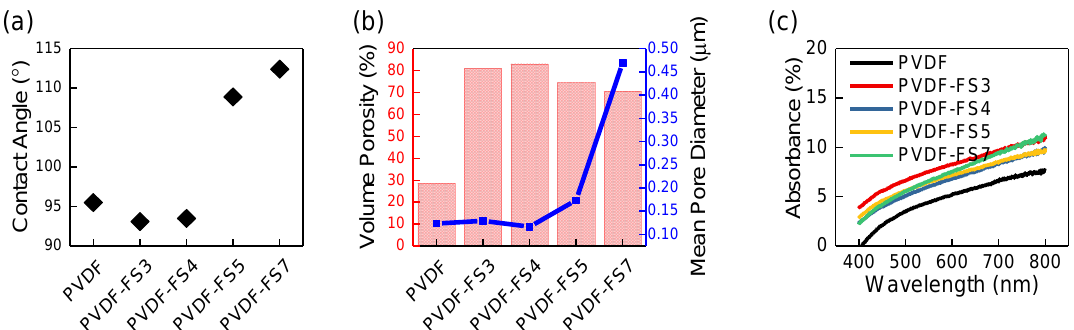
Figure 4. ( a ) Contact angles ( b ) Porosity and Mean flow pore diameter, and ( c ) absorbance measurements for our PVDF-FS membranes. The results show that the PVDF-FS4 membrane resembled the lowest contact angle, the smallest mean pore diameter, and the largest volume porosity, indicating that there was an optimal FS content value to achieve the desired properties. All membranes showed similar absorbance behavior over all of the wavelengths studied.